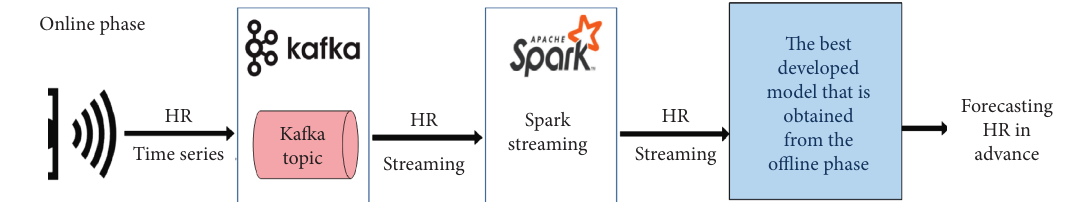
Figure 1: The architecture of HR forecasting